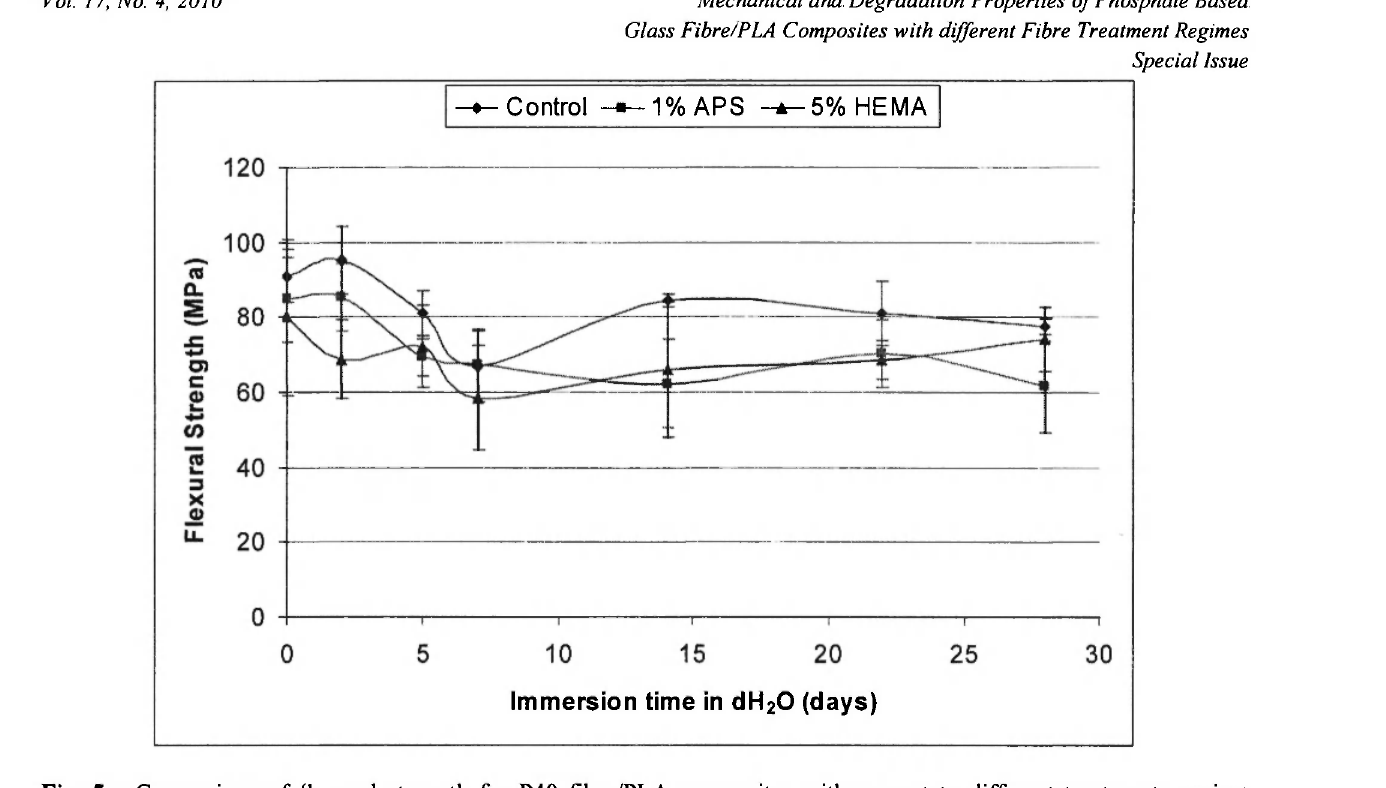
Fig. 5a: Comparison of flexural strength for P40 fibre/PLA composites with respect to different treatments against immersion time in deionised water at 37 °C. Specimens were prepared via film stacking process